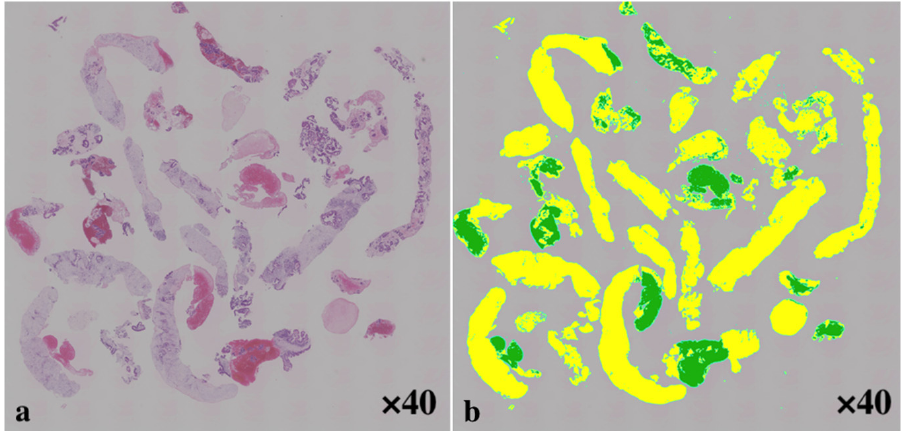
Figure 2. Histological evaluation ( a ) Hematoxylin and eosin staining (H and E, ×40) of a gross specimen obtained from the pancreatic cancer using a 22-gauge Franseen needle, viewed in a low power field. ( b ) Measuring the area of the specimen (green), excluding the blood clots (yellow), using imaging software (BZ-X800; Keyence Corporation, Osaka, Japan).